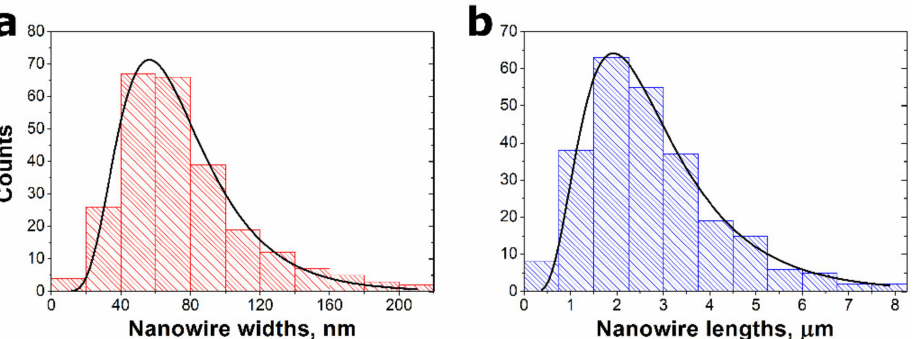
Figure 3. Distributions widths ( a ) and lengths ( b ) of SbSI nanowires in the SbSI–TiO 2 nanocomposite. The black lines represent log-normal functions expected for the nanoscale object size distribution described by Equation (1). The values of the fitted parameters of Equation (1) are given in the